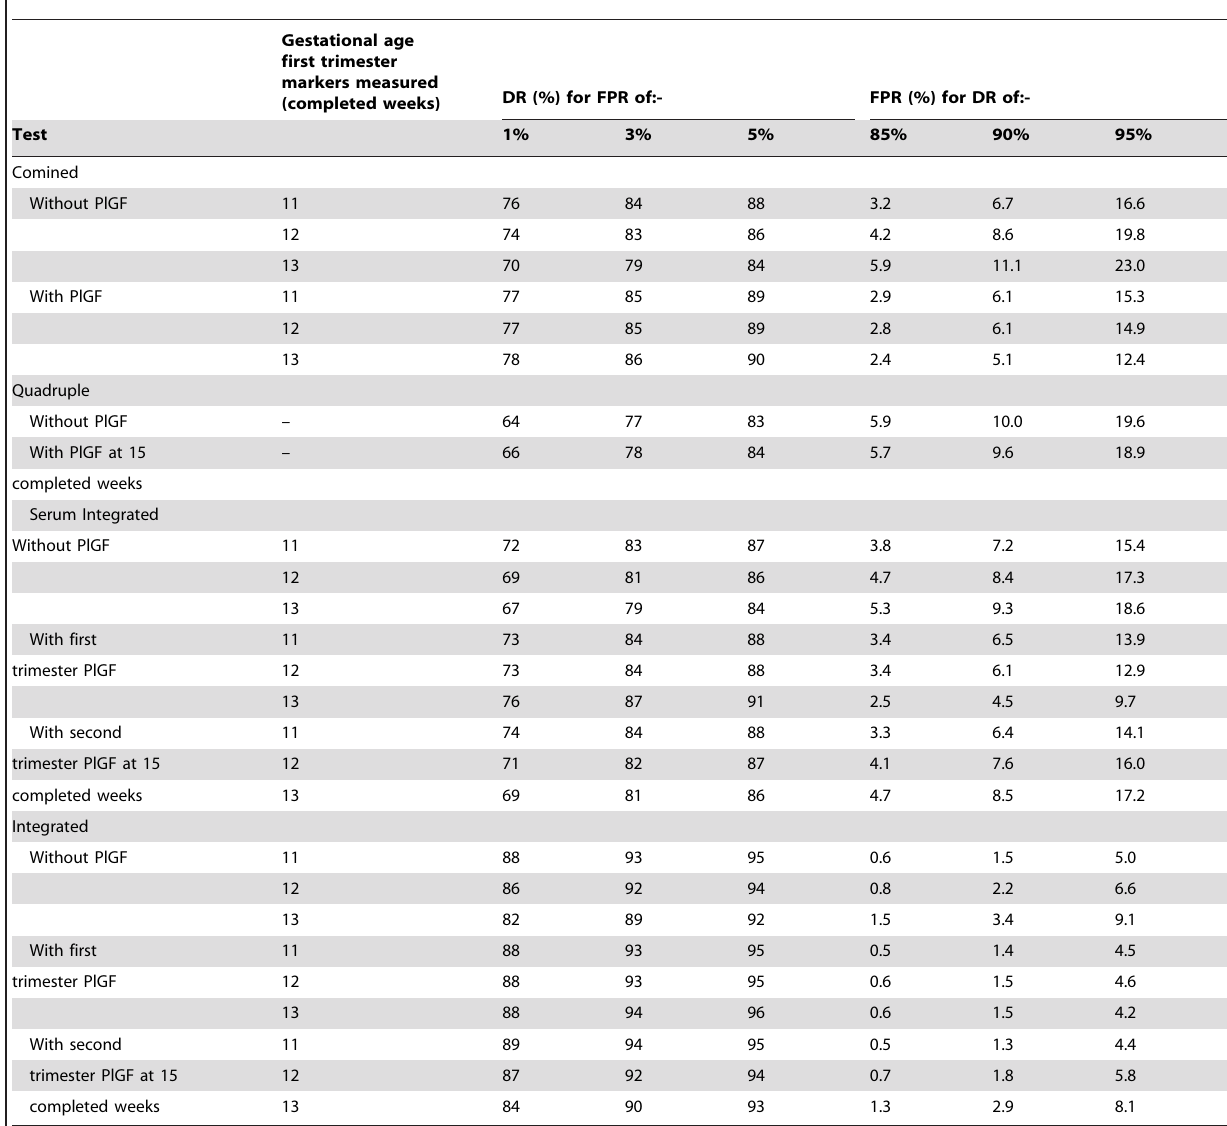
Table 3. Screening performance according to detection and false-positive rates of the Combined, Quadruple and Integrated tests with and without the addition of first or second trimester placental growth factor (PlGF) according to gestational age markers are